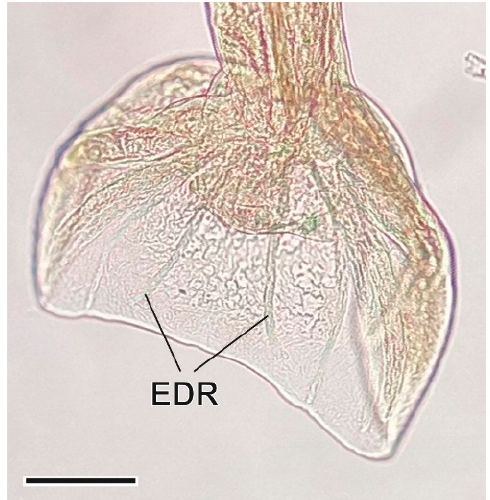
Figure 9. Caudal bursa of a Heligmosomum costellatum male. EDR, externodorsal rays. Scale bar = 100 µm.